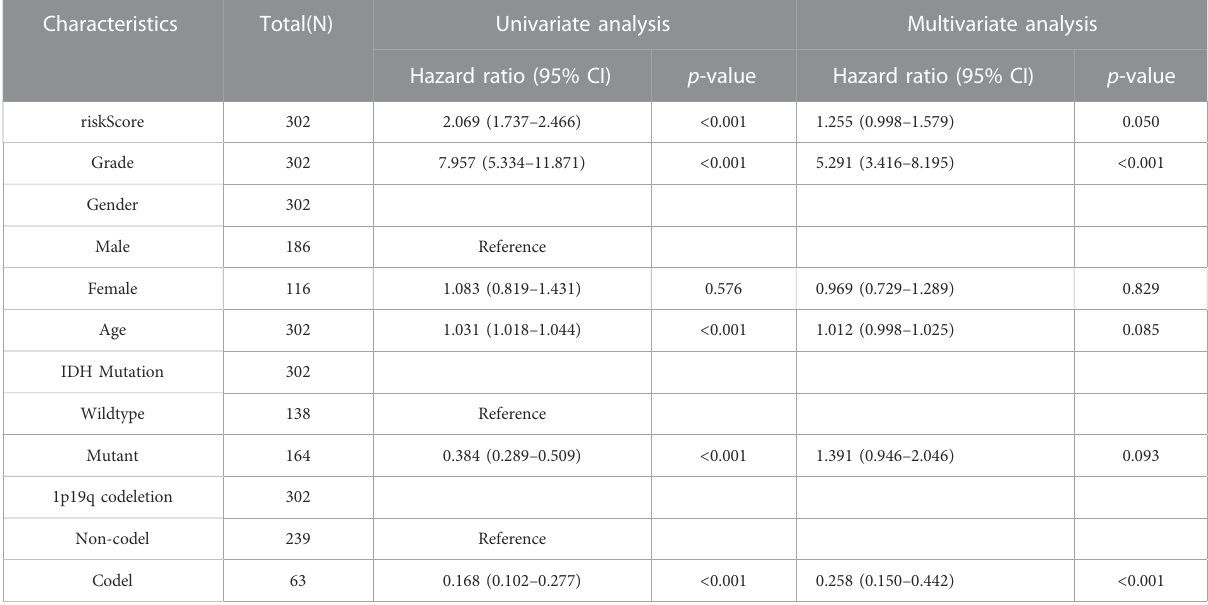
TABLE 5 The SIRT-Based signature and clinical features were analyzed by OS-based univariate and multivariate Cox regression in the TCGA database.